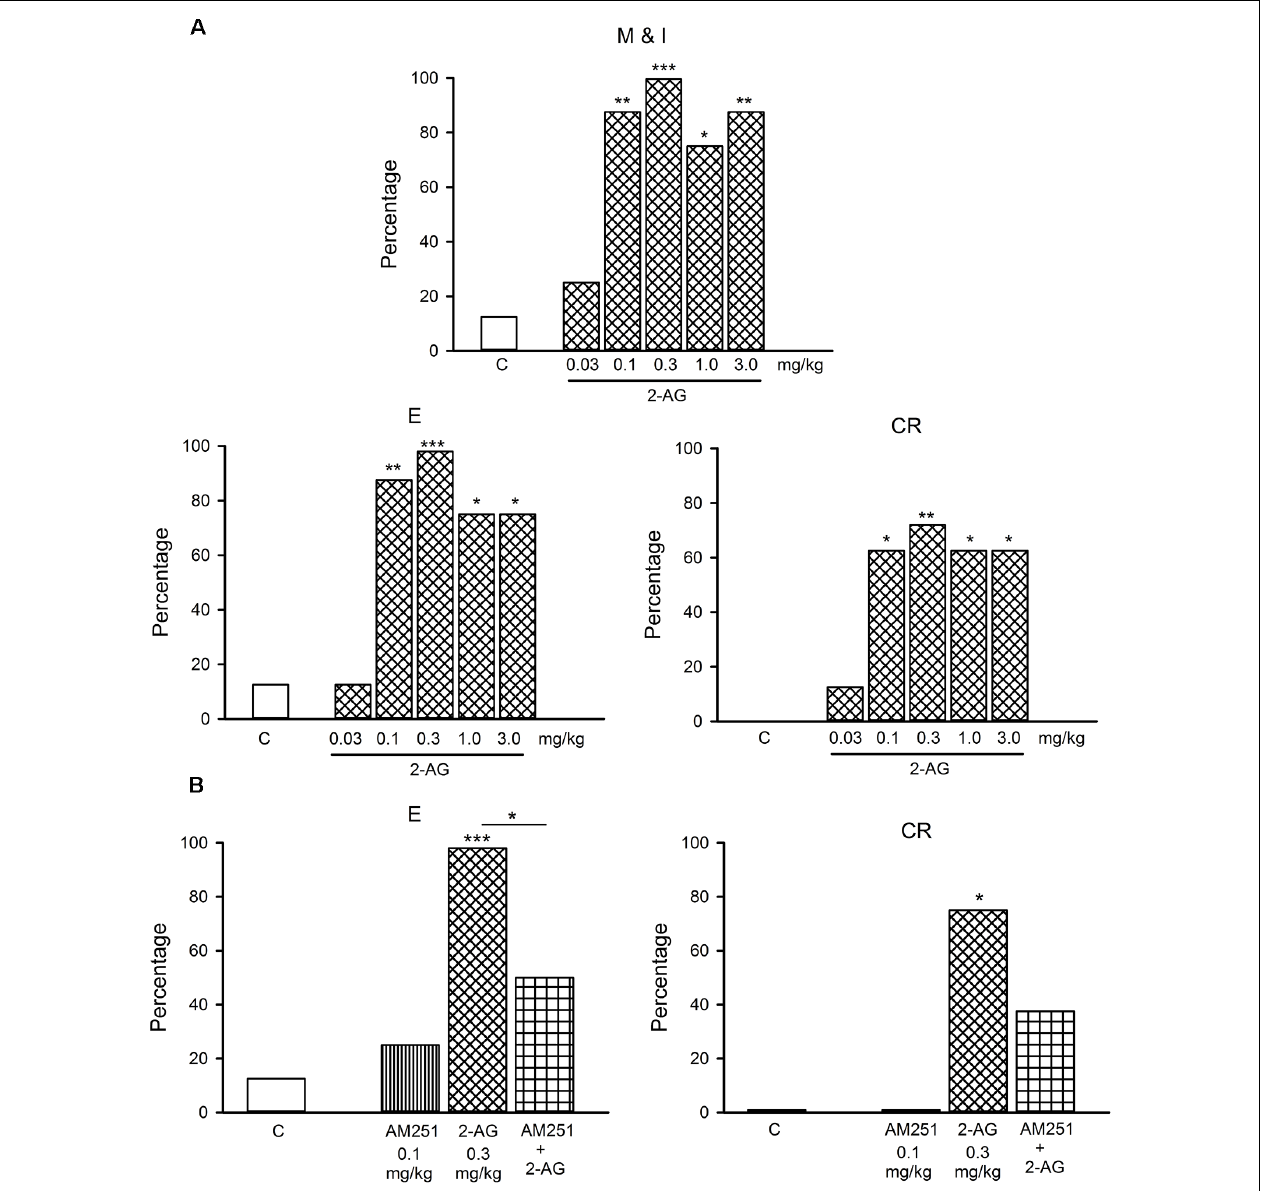
FIGURE 4 | (A) Dose-response curve of the effects of different doses of 2-AG (0.03–3.0 mg/kg) or vehicle (C) on the percentage of sexually satiated rats that exhibited the different sexual behavior responses: mount and intromission (M and I), ejaculation (E) and copulation resumption after ejaculation (CR). Fisher F test, ∗ P < 0.05, ∗∗ P < 0.01, ∗∗∗ P < 0.001 vs. C. Panel (B) shows that the CB1 receptor antagonist, AM251 (0.1 mg/kg), blocks the reversal of sexual exhaustion induced by 0.3 mg/kg 2-AG, i.e., the increase in the percentage of satiated rats ejaculating (E) and resuming copulation after ejaculation (CR). Fisher F -test ∗ P < 0.05; ∗∗∗ P < 0.001; n = 8 for each group. Asterisks over bars indicate statistical significance vs. the control group; other comparisons are indicated.